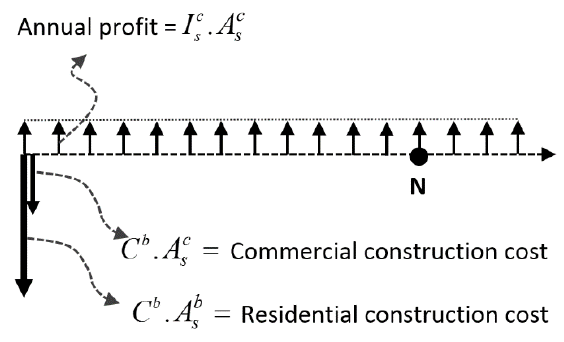
Figure 3. The investment and income flow of the private sector